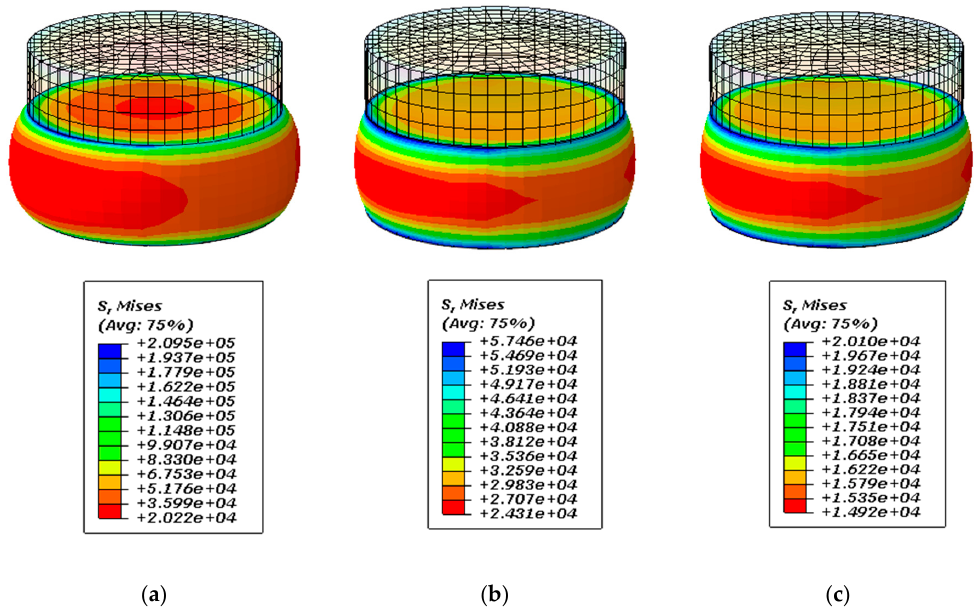
Figure 9. Stress distribution of PU SMP foams at different temperatures at the end of loading. The stress contours are related to the stress-strain results of the models illustrated in Figure 8 for ( a ) T = 35 ◦ C, ( b ) T = 55 ◦ C, and ( c ) T = 75 ◦ C.